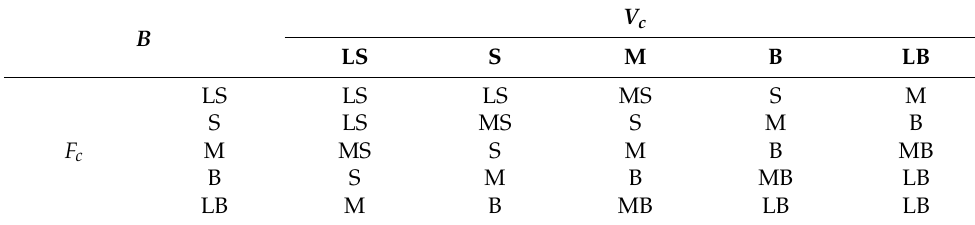
Table 2. Fuzzy rules of desired damping coefficient B